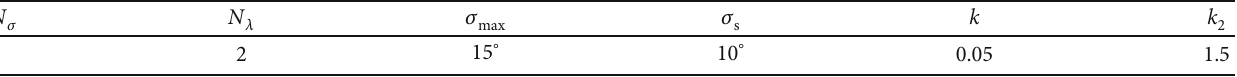
Table 3: Guidance coe ffi